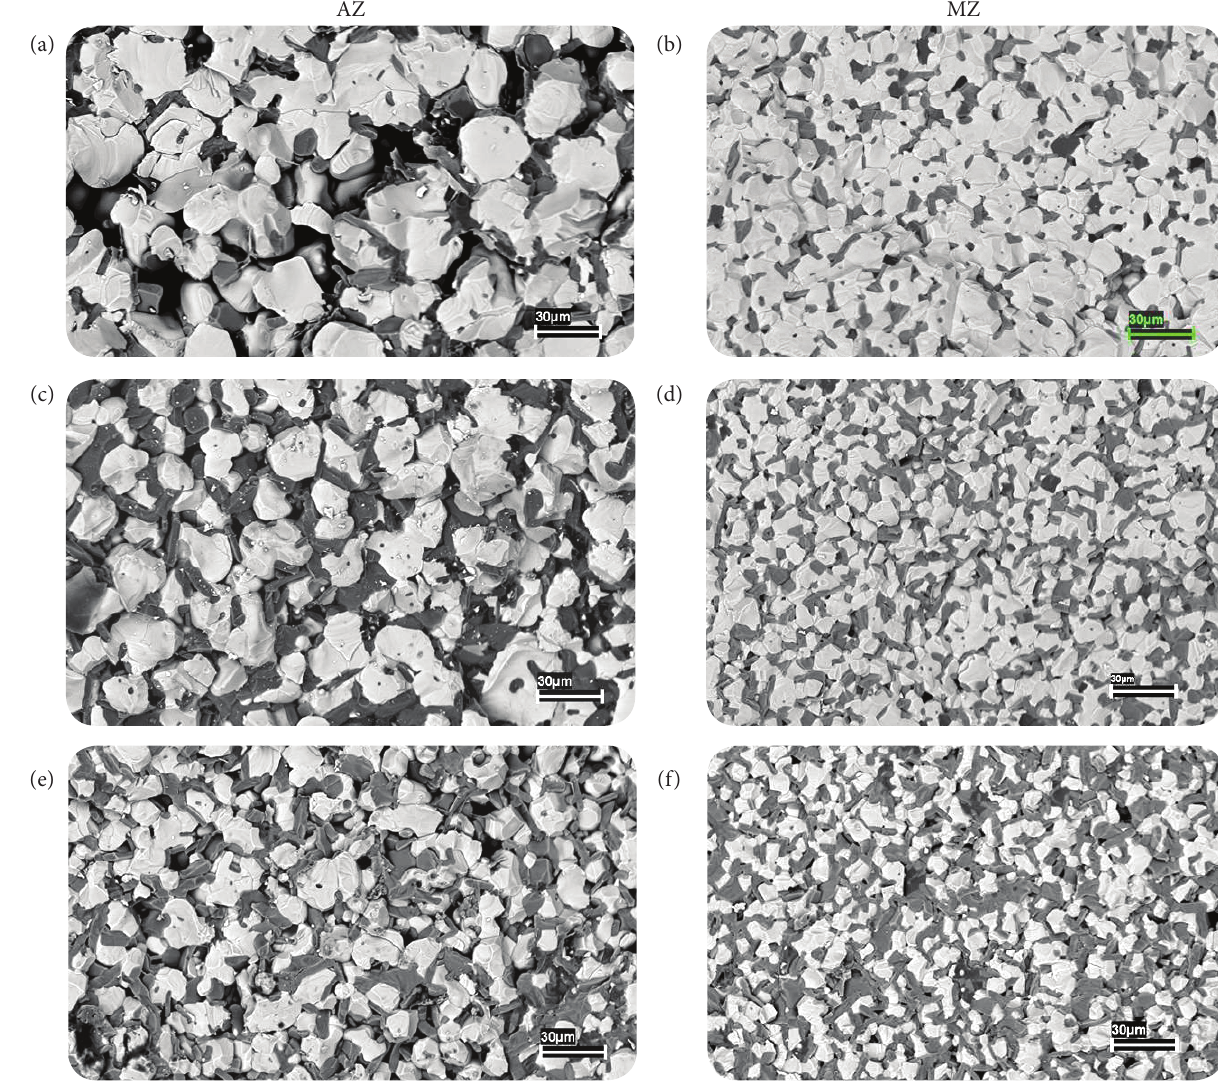
Figure 7. SEM (BSE) images depicting the microstructures of the ZrB -SiC composites processed with AZ and MZ powder 2 sintered at 2050/1h: (a) and (b) 10% SiC; (c) and (d) 20% SiC; (e) and (f) 30%